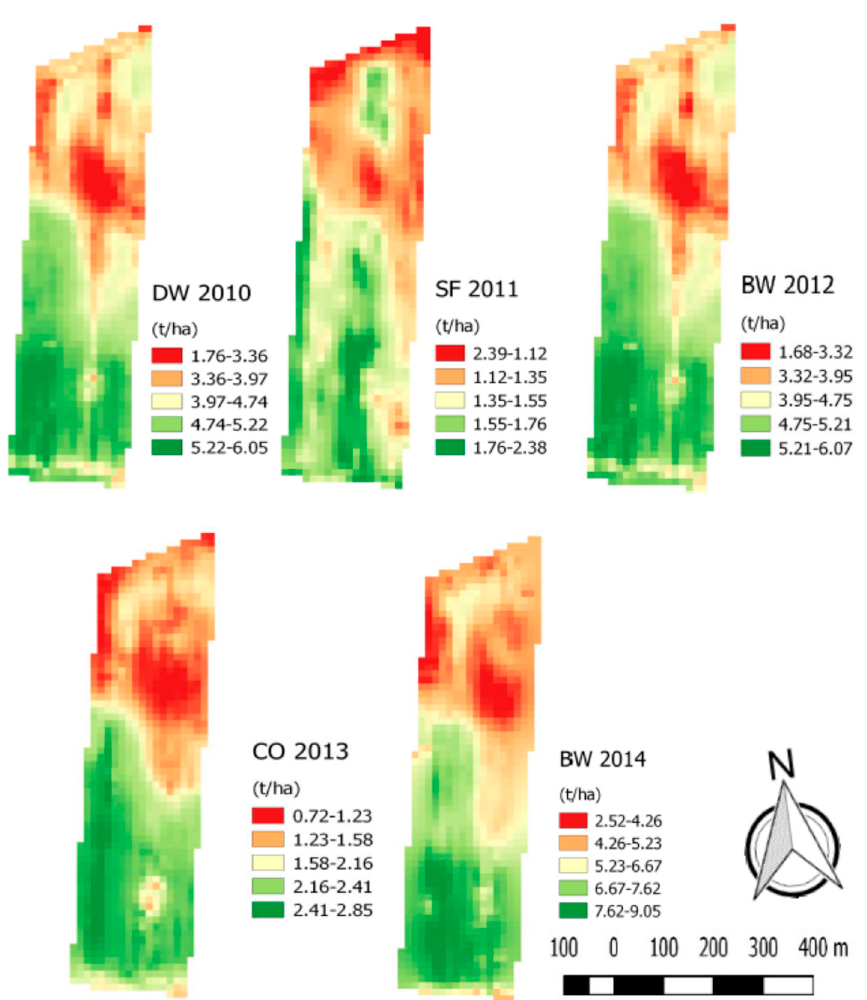
Figure 2. Spatial variability maps of crop yields in the five years with 10 m cell size (1106 pixels in the 11.07 ha field). 11.07 ha